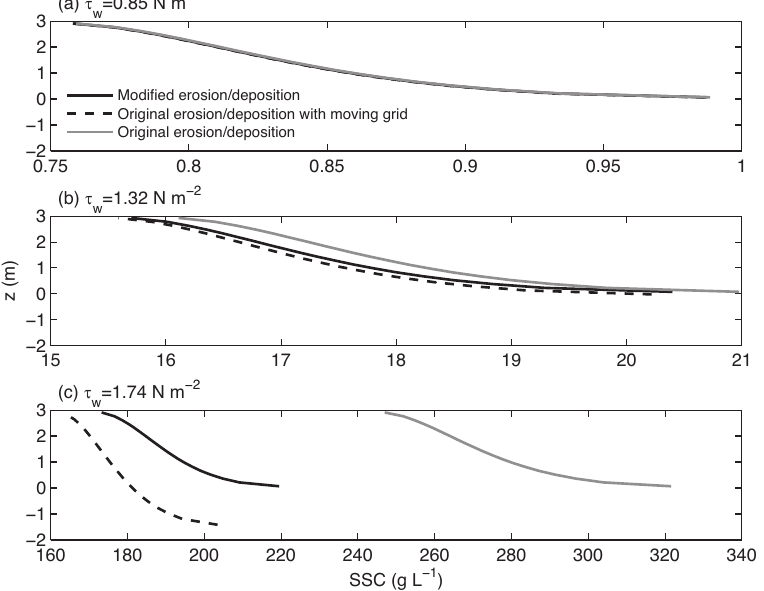
Figure 2. Vertical profiles of SSC for τ w = 0.85 ( a ), 1.32 ( b ), and 1.74 N m − 2 ( c ) in the cases of modified erosion/deposition formulation with fixed grids (black solid line), original formulation with moving grids (black dashed line), and original formulation with fixed grids (gray solid line) in different wave